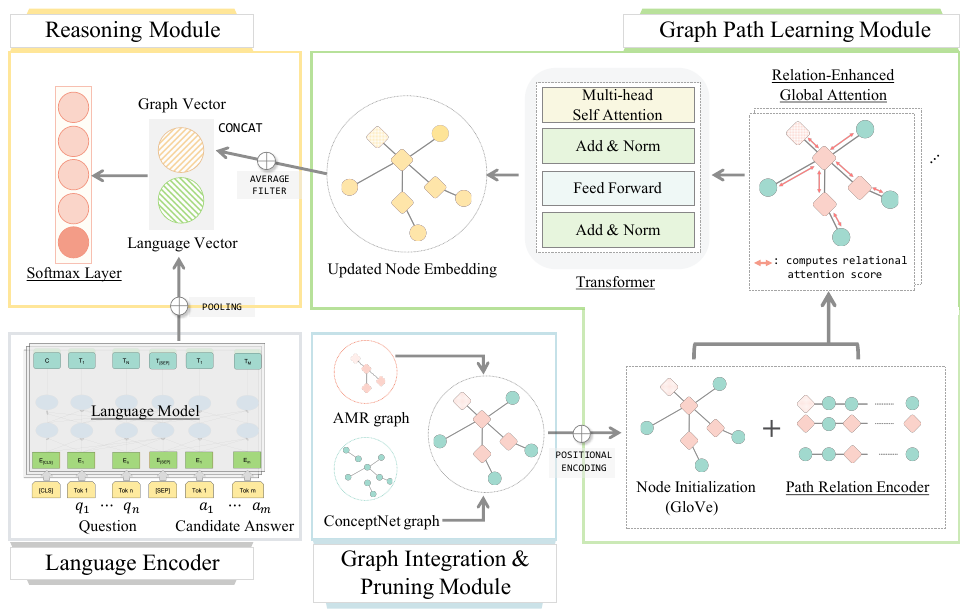
Figure 3. Overview of AMR-CN reasoning